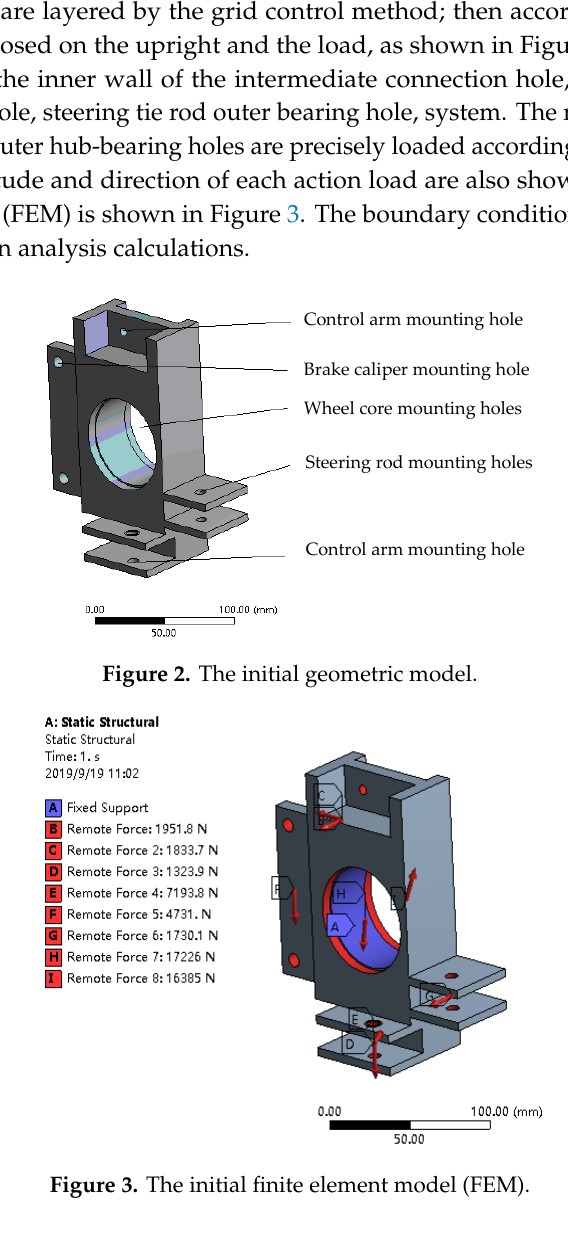
Figure 3. The initial finite element model (FEM).